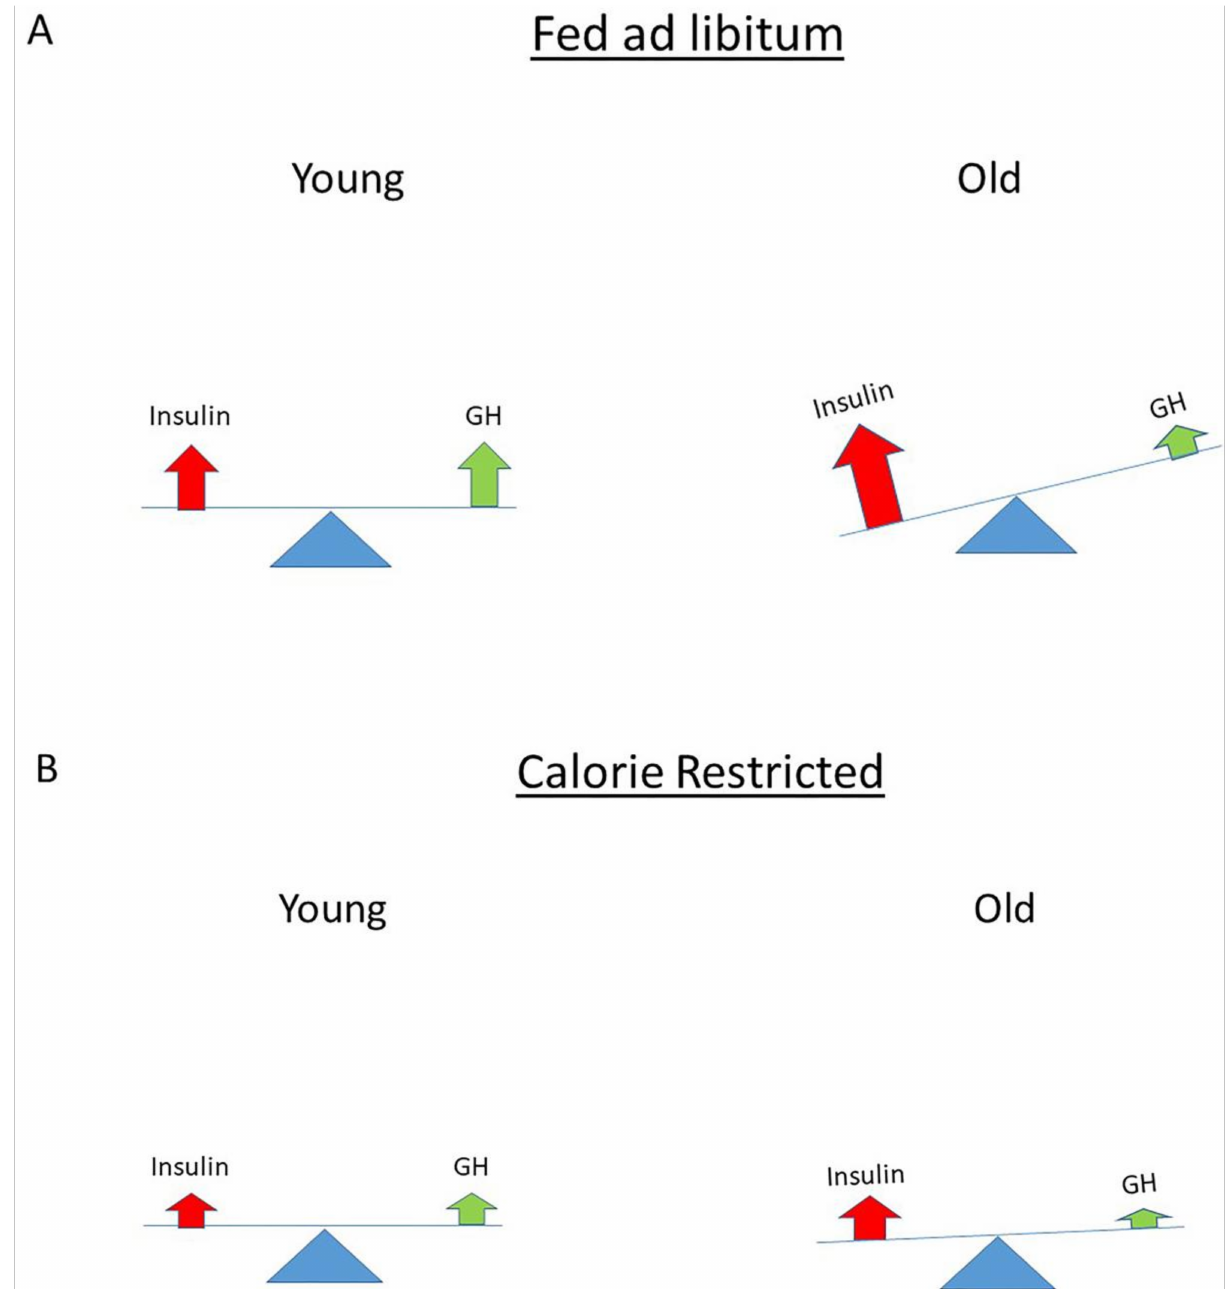
Figure 6. In the view of Parr, nutritionally driven “normal” insulin exposure is central to imbalance of the insulin–growth hormone axis (insulin–GH axis) [157,158]. ( A ) At young age there is balance in the insulin–GH axis. However, when there is (excessive) food intake ad libitum, a progressive imbalance develops in the insulin–GH axis with aging. This imbalance is the direct consequence of a food-induced increase in insulin secretion and the five-fold decline in GH secretion, which normally occurs between the age of 18 and 80. Due to the progressive imbalance in the insulin–GH axis with aging the decline in reserve capacity of cells and organ functions is accelerated. ( B ) Calorie restriction started at a young age will cause (a lifelong) lower insulin and GH secretion. As a consequence of calorie restriction, cumulative lifetime exposure to insulin at the same age will be less and lifespan will be extended by better maintaining the balance in the insulin–GH axis: this will result in long-term low (but functional) insulin levels and a high insulin receptor sensitivity (see text for more details). However, after the third decade of life, there is a progressive decline of GH secretion with “normal” to high insulin [158]. With aging, this causes a progressive imbalance in the insulin–GH axis, leading to a gradual decline in cell and organ functions and